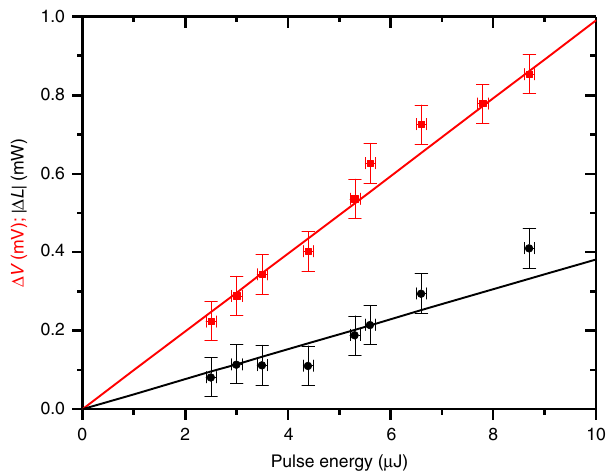
Fig. 4 Amplitude of acoustic modulation measured as a function of optical pulse energy. Amplitude of voltage Δ V (red squares) and power Δ L (black circles) perturbation signals for the fi rst strain-induced pulse, measured at a bias voltage V b = 5.38 V. Error bars represent the measurement errors on the pulse energy and amplitudes. The lines are linear fi ts to the data. Source data are provided as a Source Data fi le.